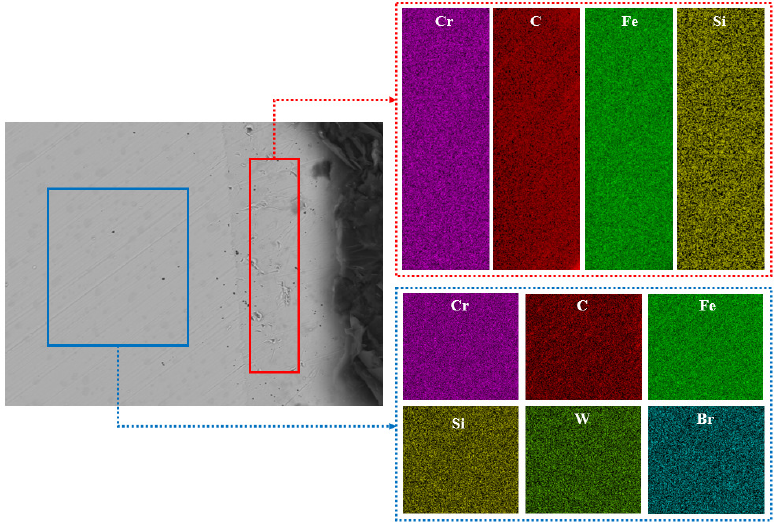
Figure 11. EDS of the rear bearing’s rolling element wear delamination (serviced).